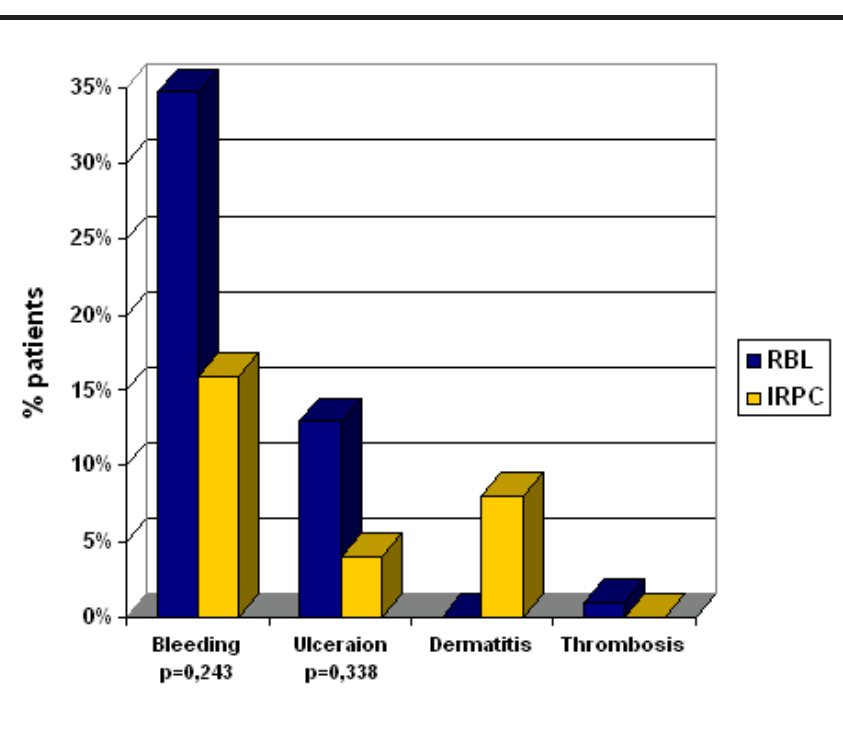
In group 1, two patients had perianal dermatitis treated conservatively and in group 2, one patient developed thrombosis in the banded hemorrhoids. He was submmited to hemorrhoidectomy with good results. The overall incidence of complications are depicted in Figure